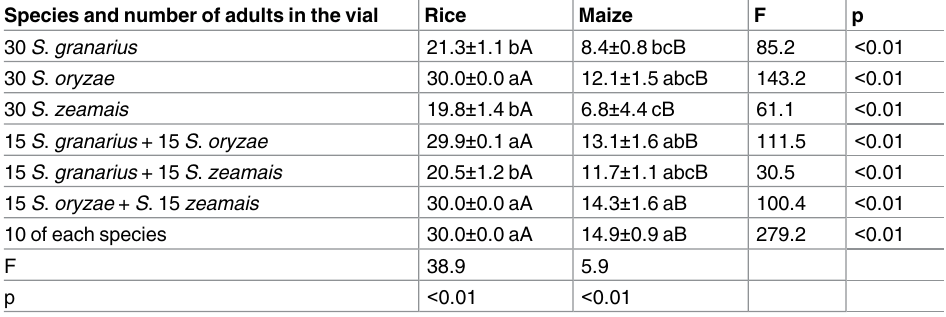
Table 4. Mean number of IDK ± SE per vial in a sub-sample of 30 kernels for vials containing different combinations of S . granarius , S . oryzae and S . zeamais on rice or maize. Species and number of adults in the vial Rice Maize F p